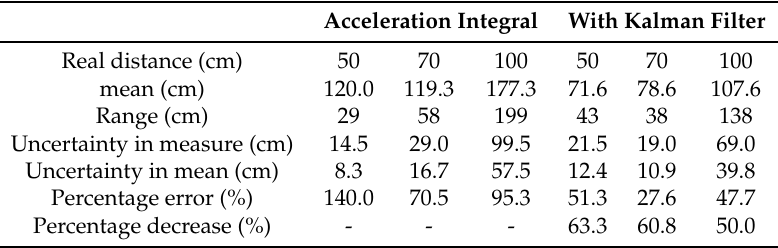
Table 2. Displacement along the x -axis measured with the